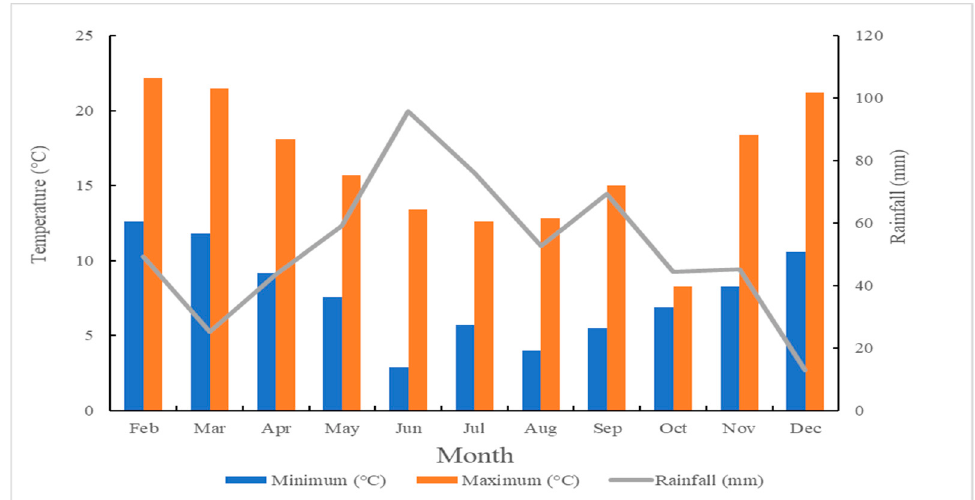
Figure 3. The mean monthly rainfall and minimum and maximum temperature at Pioneer, Tasmania from February to December in 2019 (obtained from the SILO, https://www.longpaddock.qld.gov.au/silo/point-data/ accessed on 3 July 2020). Table 5. The physicochemical properties of topsoil to 200 mm depth, which represents the distribu- tion of the majority of the root profile of K. ambigua in the field trial.